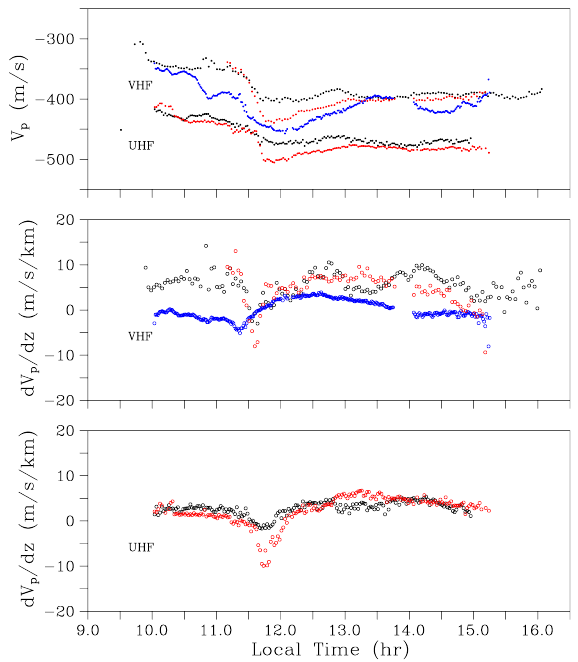
Fig. 6. Doppler shifts of red-shifted type-1 echoes at 102 km al- titude derived from spectrograms like those in Figs. 4 and 5 along with their altitude derivatives. Black, red, and blue symbols repre- sent echoes from 0, 23/24, and 51 degree west zenith angles, respec- tively. Negative Doppler shifts imply propagation away from the radar. Positive derivatives imply decreasing phase speed magnitude with increasing altitude. The curves were derived from backscatter between 99–105km altitude using linear